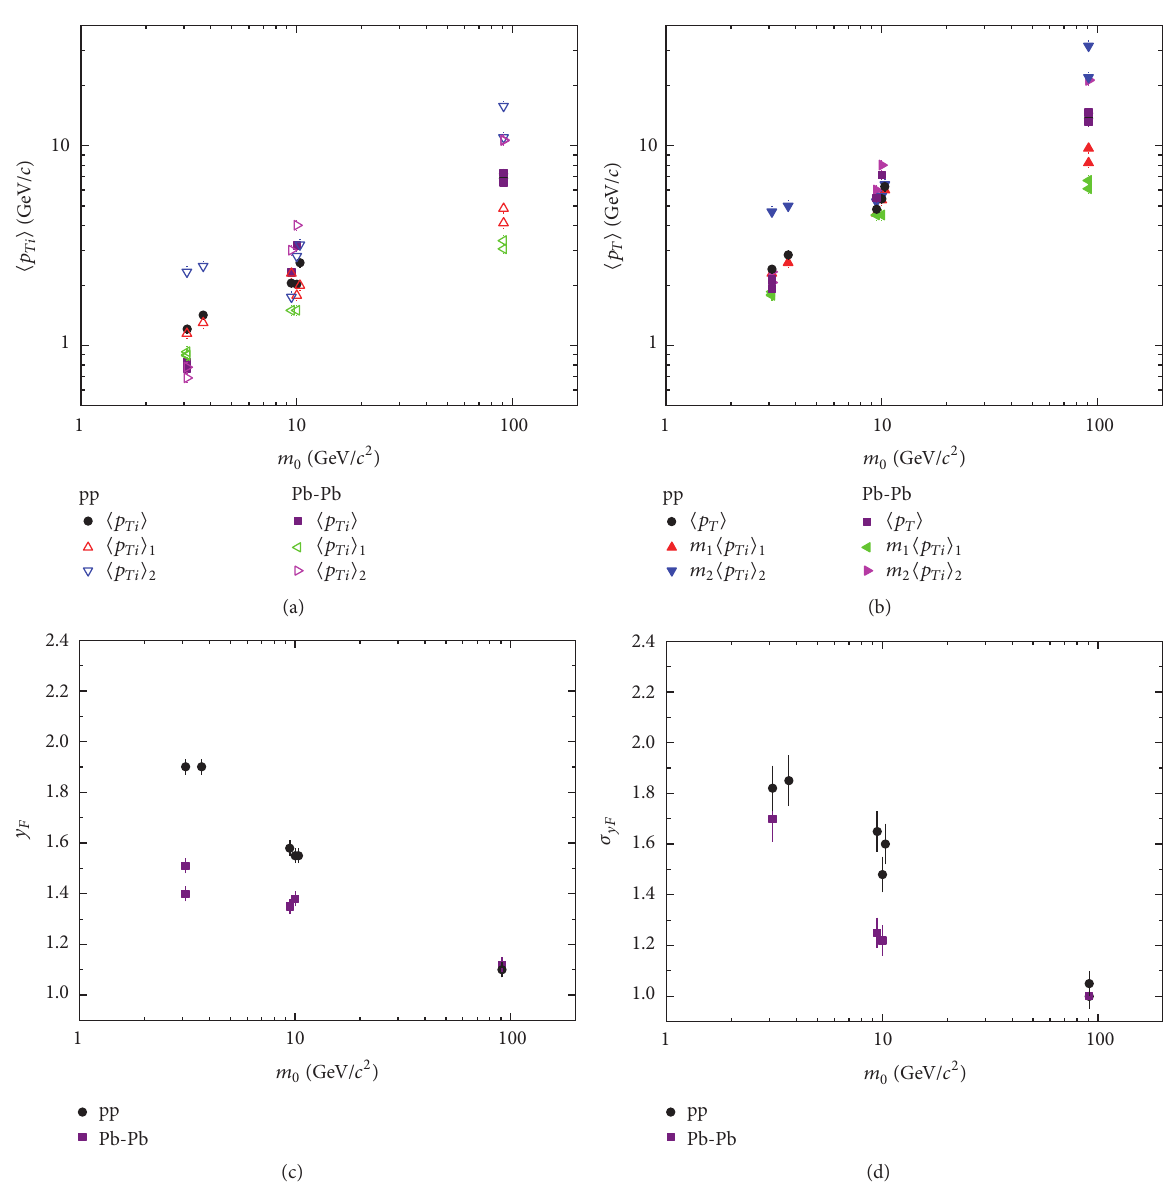
event patterns are small in some details. Generally, these small differences in restrictions do not affect largely the global shapes and contour profiles of